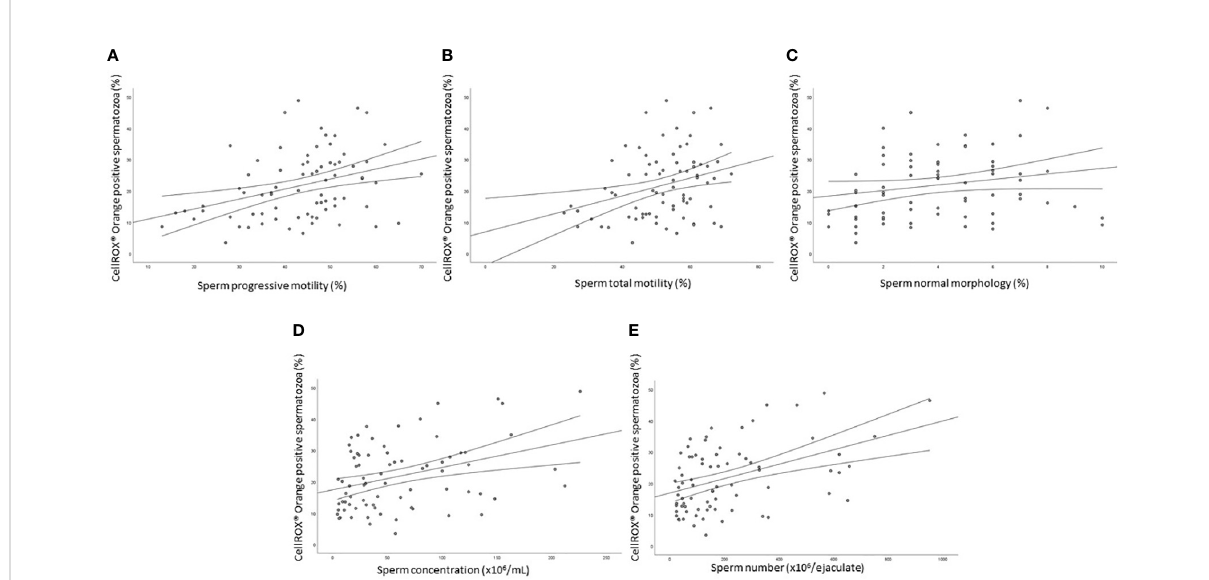
FIGURE 4 Scatter plots representing the relationships between the percentage of CellROX ® Orange positive spermatozoa and progressive ( A , R=0.4, p<0.01) and total ( B , R=0.3, p<0.05) motility, normal morphology ( C , R=0.2, p<0.05), concentration ( D , R=0.3, p<0.01) and number ( E , R=0.4, p<0.01) in 77 subjects.